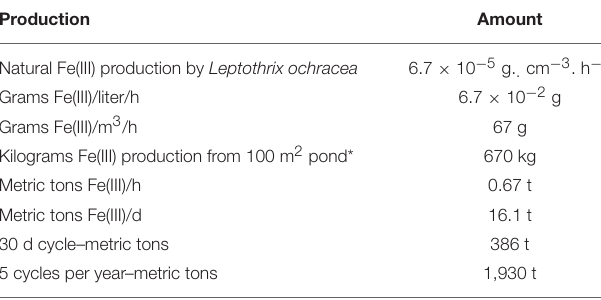
TABLE 2 | Production estimate for biogenic iron